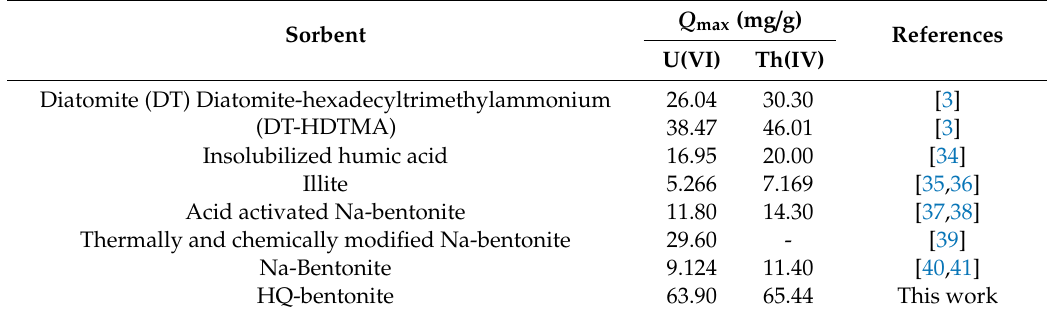
various sorbents at room temperature.